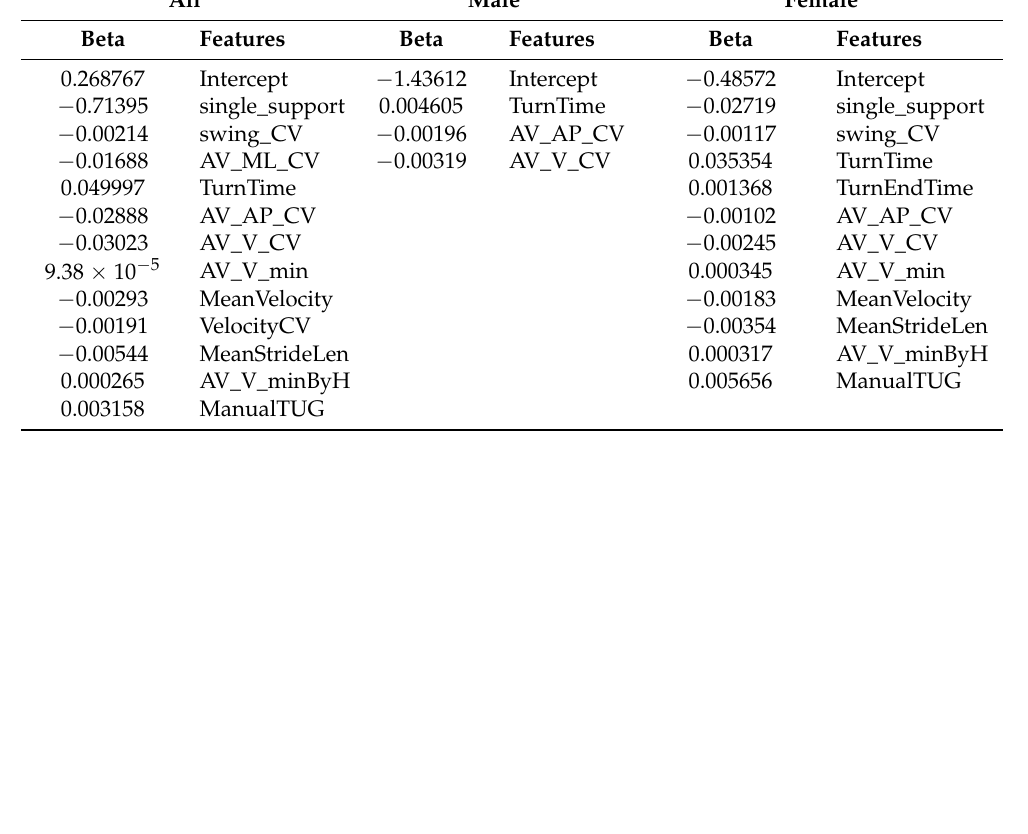
Table A6. TD-All falls count model coefficients. Beta refers to Poisson regression coefficients, chosen through an elastic net procedure.